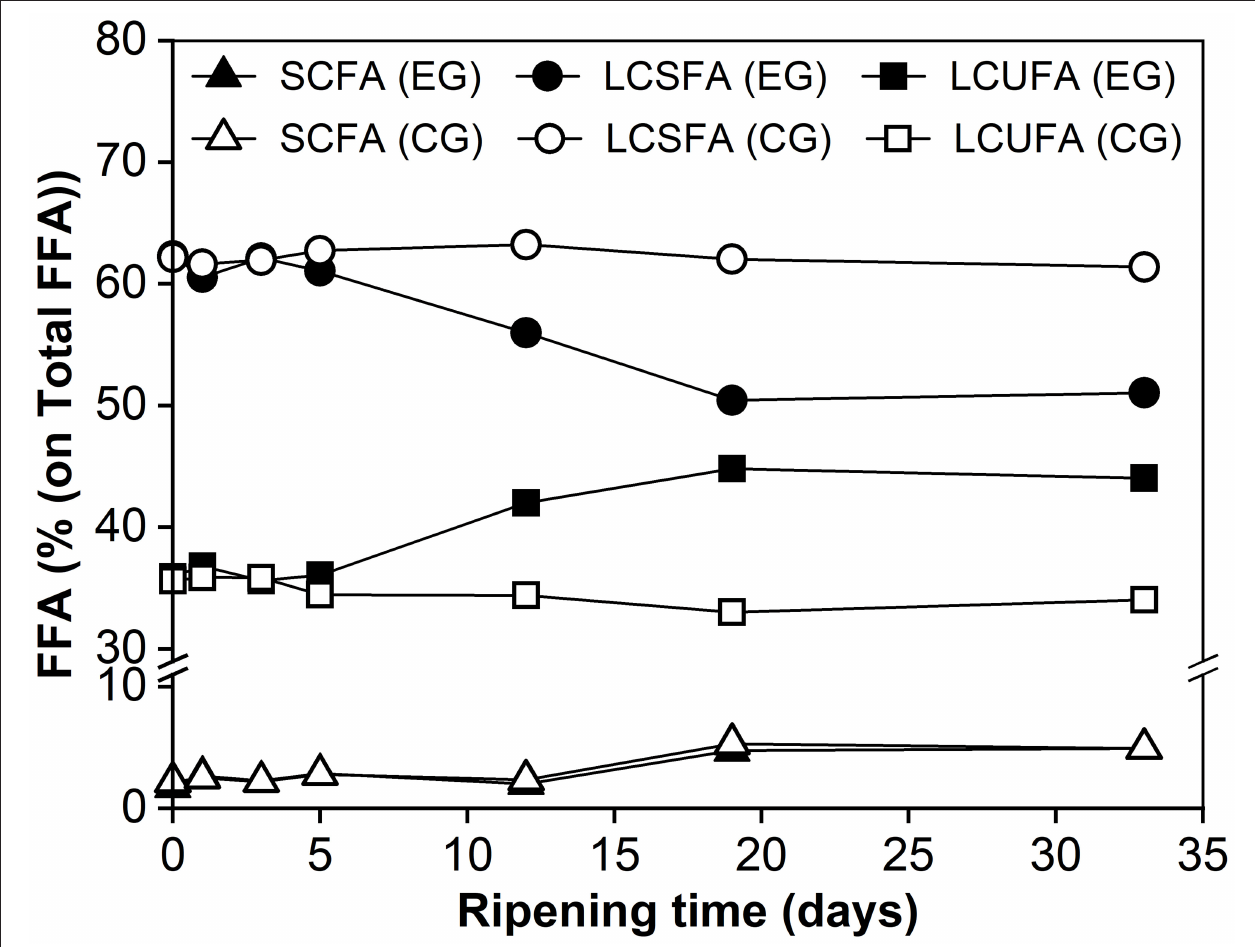
FIGURE 3 | The relative abundance of free fatty acids (FFAs) categorized based on chain length and saturation degree during cheese ripening. SCFA, short-chain fatty acids (C 6 : 0 , C 8 : 0 , C 10 : 0 ); LCSFA, long-chain saturated fatty acids (C 12 : 0 , C 14 : 0 , C 16 : 0 and C 18 : 0 ); LCUFA, long-chain unsaturated fatty acids (C 16 : 1 , C 18 : 1 , C 18 : 2 ); EG, experimental group; CG, control group without inoculation of red koji